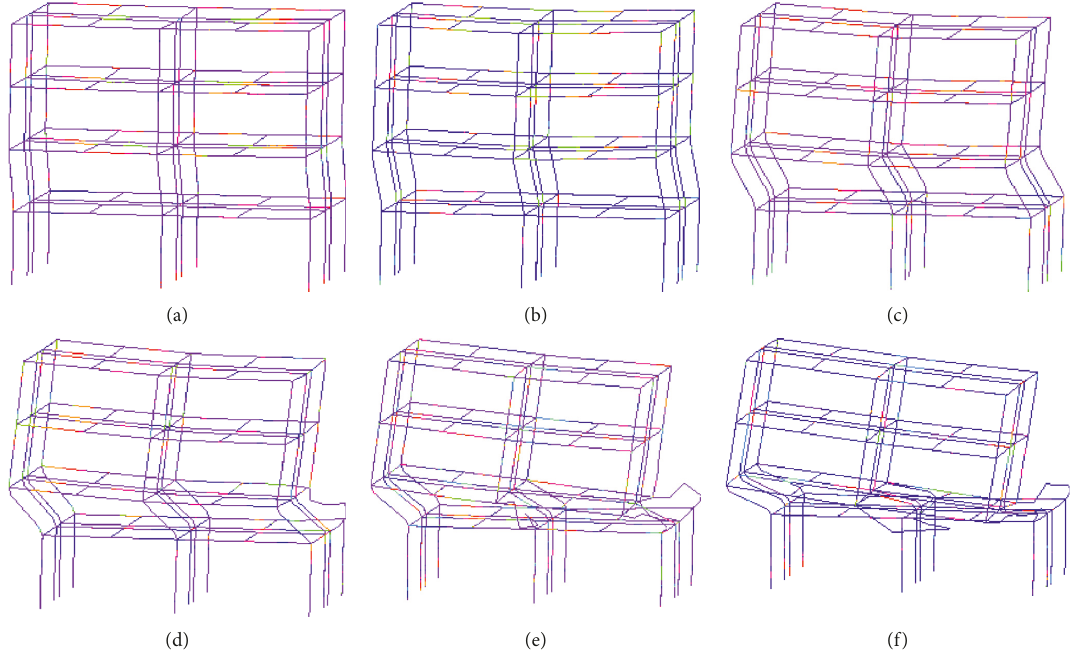
Figure 13: Collapse process of the structure subjected to three-component excitation under Taft wave considering strain rate effect.